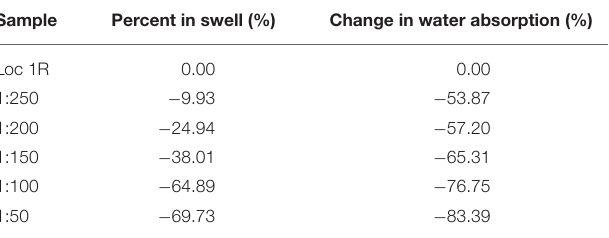
TABLE 11 | Percentage changes in percent swell (%) and water absorption (source: analysis of laboratory results).